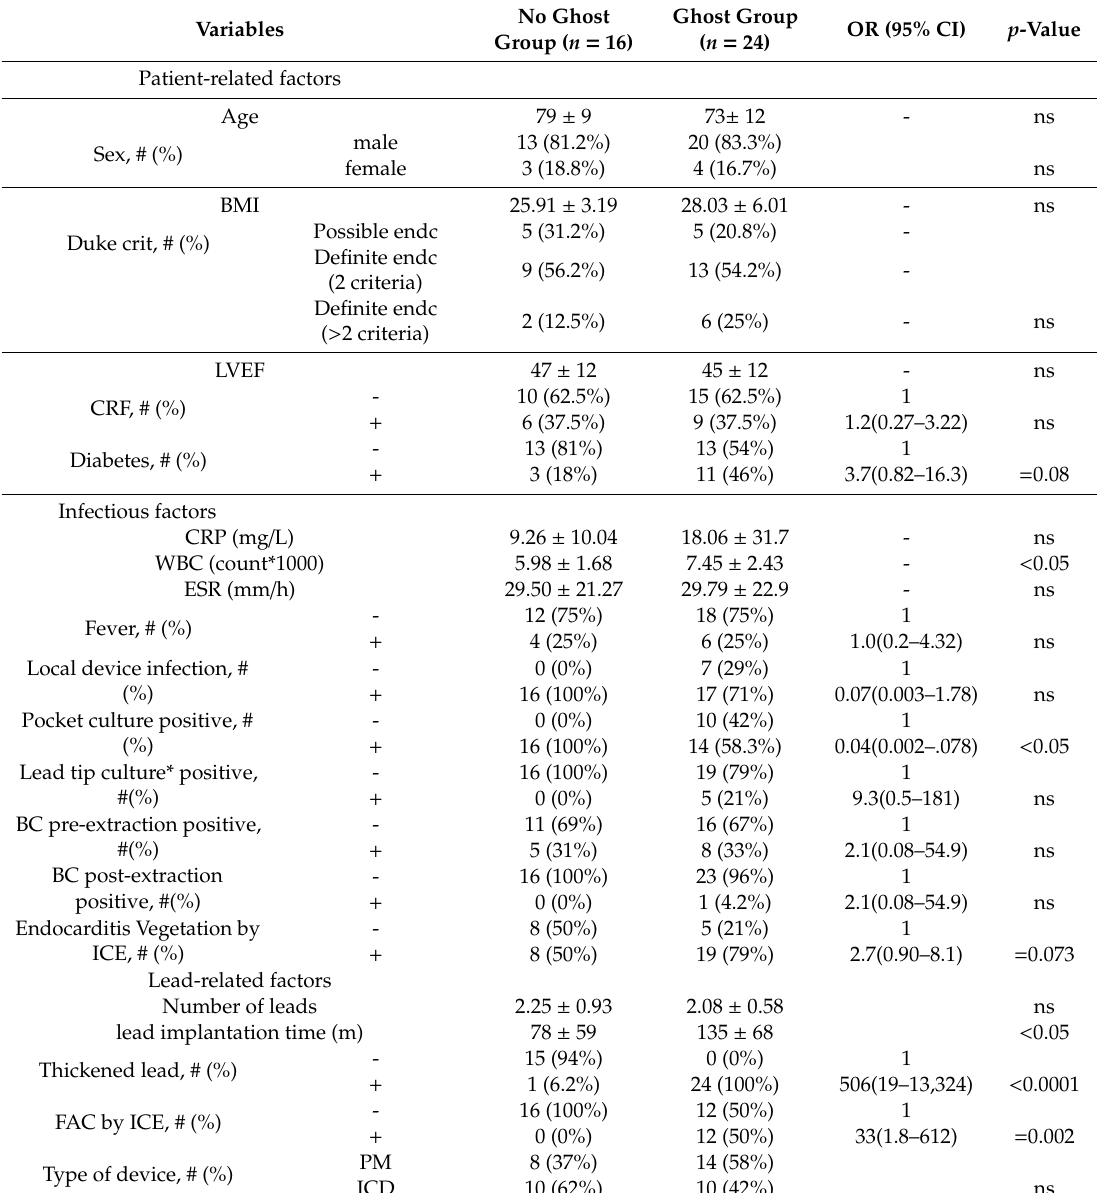
Table 3. Ghost predictors (univariate